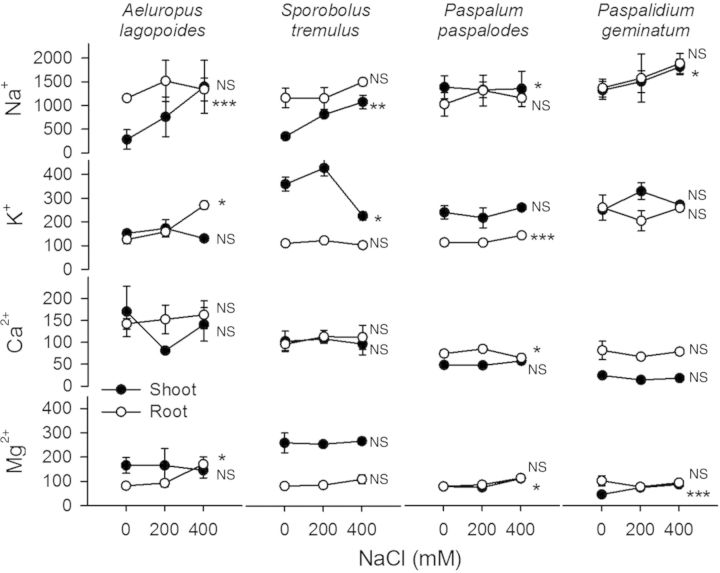
Cation (Na+, K+, Ca2+ and Mg2+) content (mmol kg−1 dry weight) in shoot and root of the salt-excreting (A. lagopoides, S. tremulus) and non-excreting (P. paspalodes, P. geminatum) grasses grown under increasing salinity treatments (0, 200 and 400 mM NaCl). Symbols indicate means (±SE) at each salinity level (n = 3). Asterisks (*, ** and ***) represent significant differences between cation contents at P < 0.05, 0.01 and 0.001 respectively; NS indicates non-significant differences among salinity treatments by one-way ANOVA.